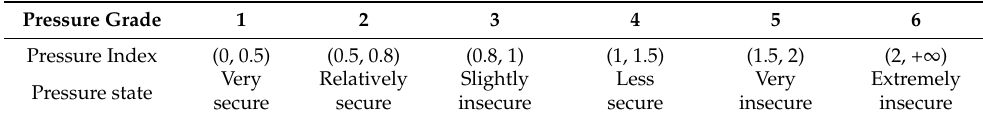
Table 3. Ecological pressure index grade.